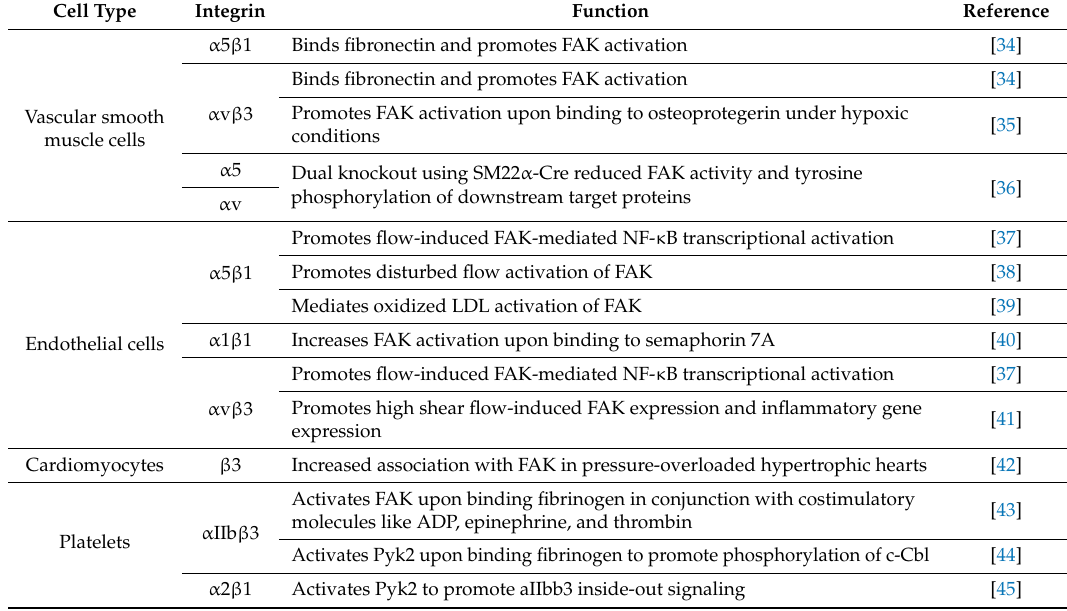
Table 1. Role of integrins on FAK family signaling in vascular cell